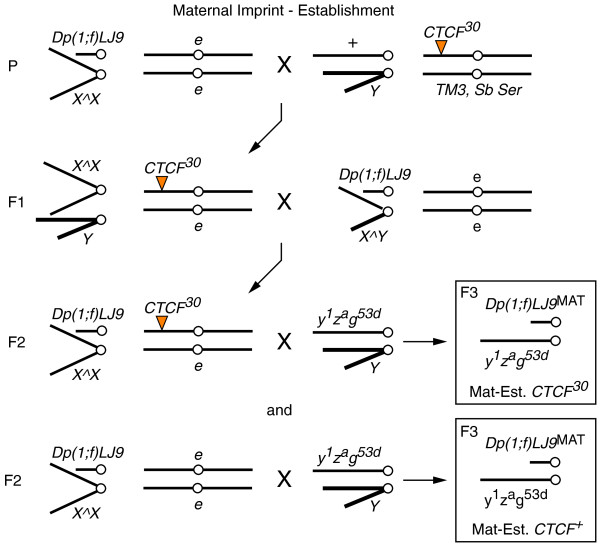
Mating schematic for testing dCTCF for an effect on maternal establishment of the Dp(1;f)LJ9 imprint. Two primary sets of progeny and an external control were generated from this cross: progeny with a maternally-inherited Dp(1;f)LJ9 mini-X chromosome from mothers with the CTCF30 mutation (Mat-Est. CTCF30) and progeny that also have a maternally imprinted Dp(1;f)LJ9 chromosome but from mothers wild type for CTCF (Mat-Est. CTCF+). External control crosses were produced by crossing F1 generation X^X/Dp(1;f)LJ9; e/e females to y1zag53d/Y males (not depicted).